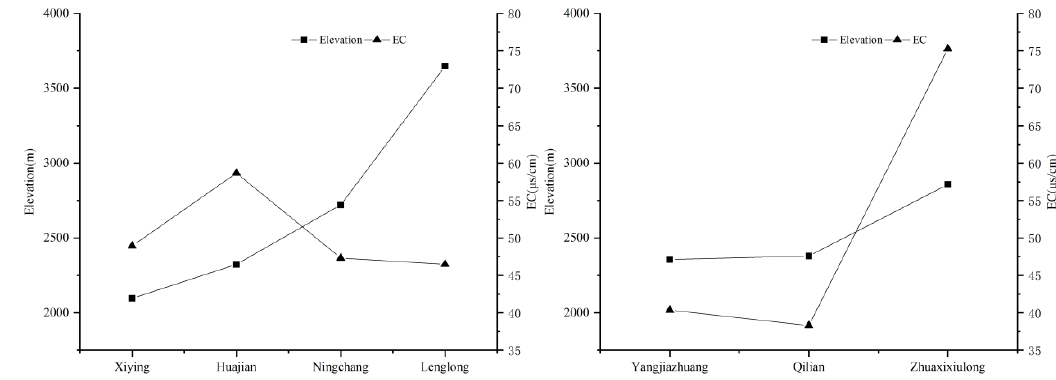
Figure 8. Changes of EC in the precipitation along with altitude in the upper reaches of the Figure8. Shiyang River.